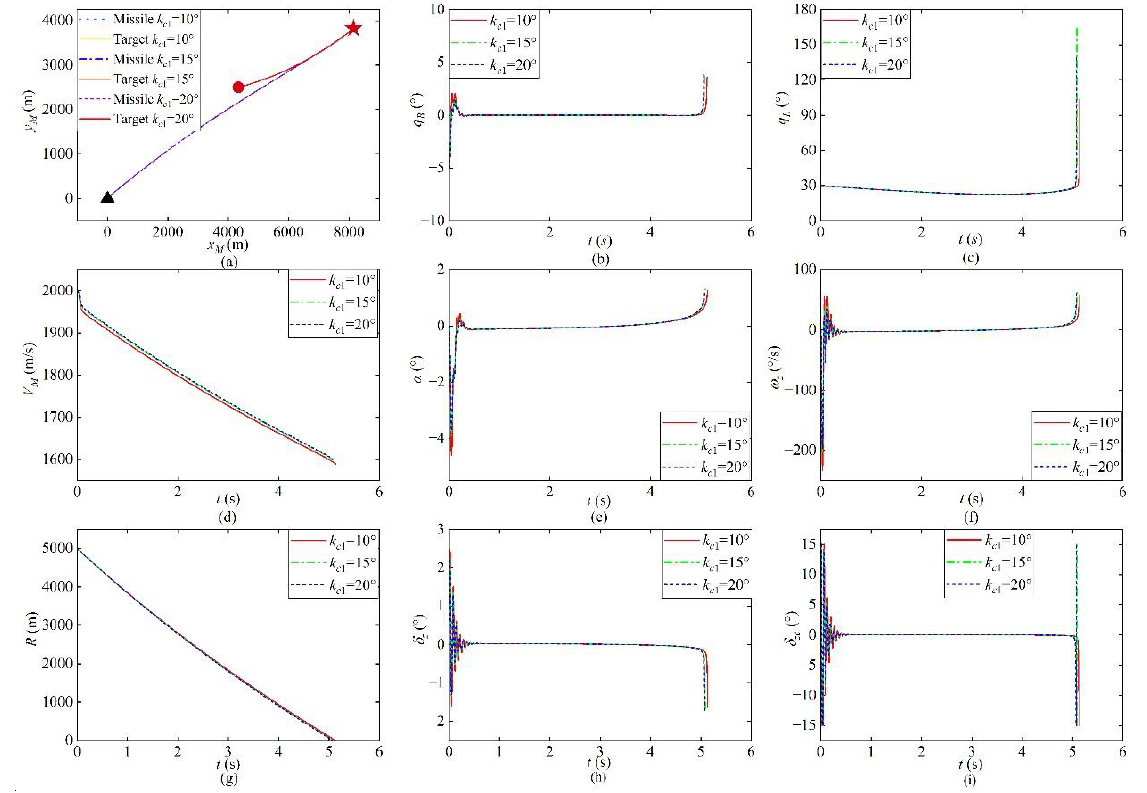
Figure 3. Simulation results under Case 1. ( a ) Missile – target pursuit trajectory. ( b ) The BLOS angle. ( c ) The LOS angle. ( d ) The velocity of missile. ( e ) The angle of attack. ( f ) The pitch angular rate. ( g ) The relative missile-target distance. ( h ) The deflection angle. ( i ) The control input. Table 4. Simulation results under Case 2.